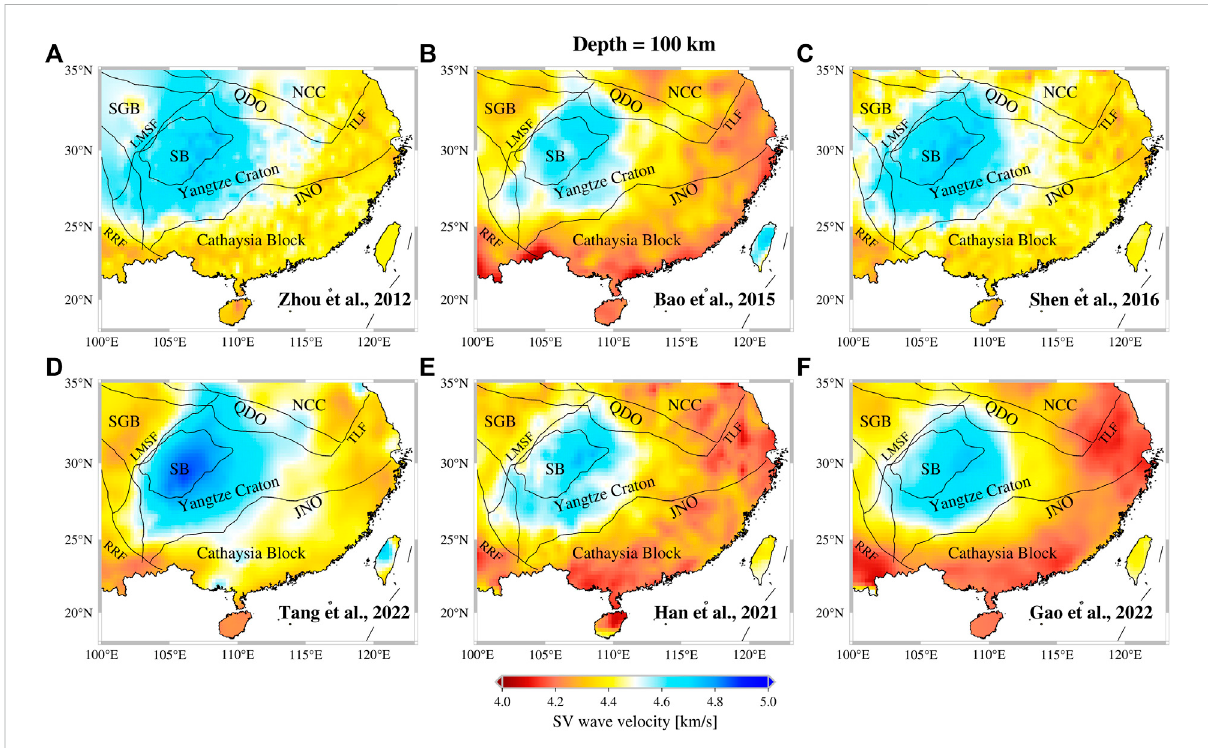
FIGURE 3 Shear wave velocity for the six SV wave models at 100 km depth from (A) Zhou et al. (2012) (B) Bao et al. (2015) (C) Shen et al. (2016) (D) Tang et al. (2022) (E) Han et al. (2021) (F) Gao et al. (2022).